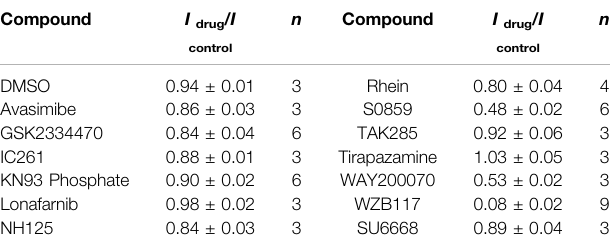
TABLE 1 | Inhibitory effects of 13 compounds on GluN1/GluN3A receptors.